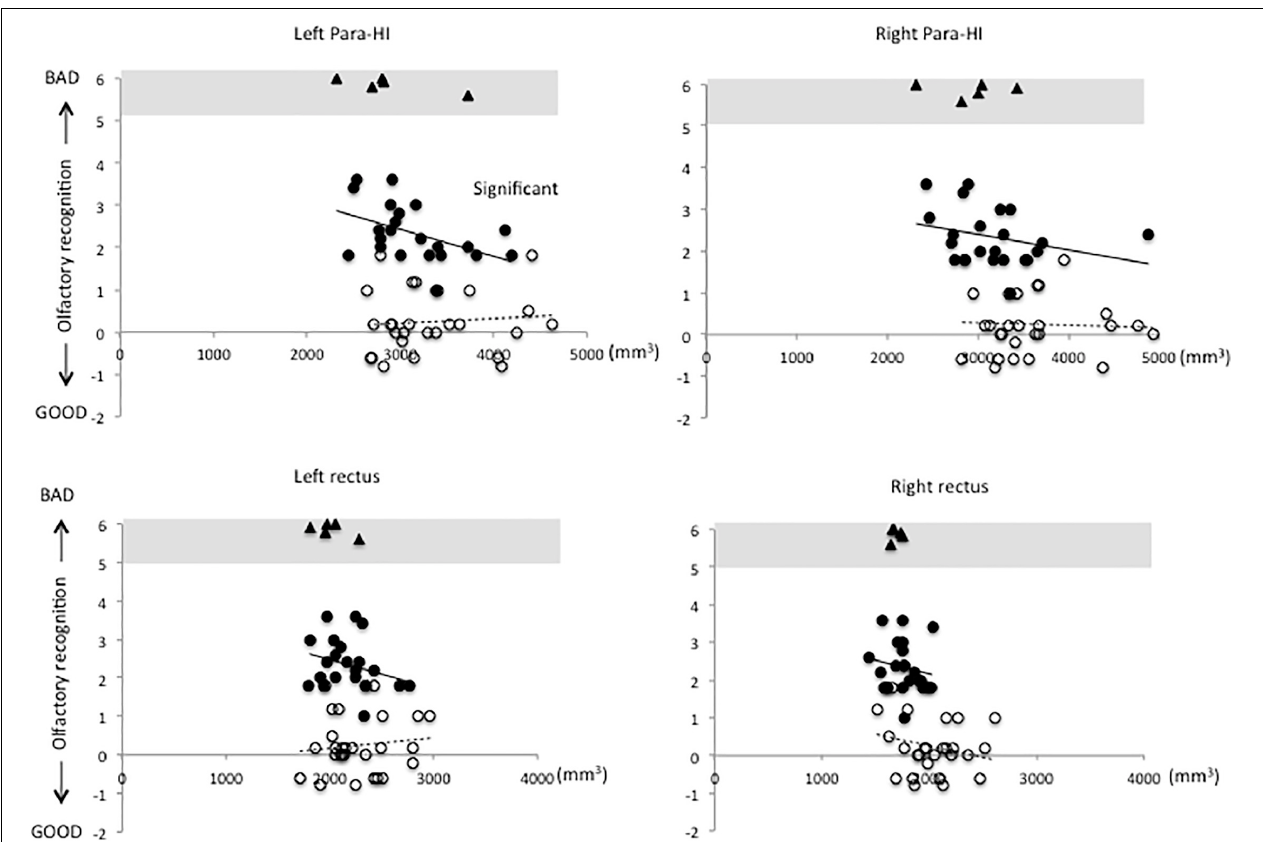
FIGURE 2 | Relationships between volumes of the parahippocampus (para-HI) and rectus and olfactory test scores in elderly and young subjects. A significant group × volume interaction was observed for the left para-HI.